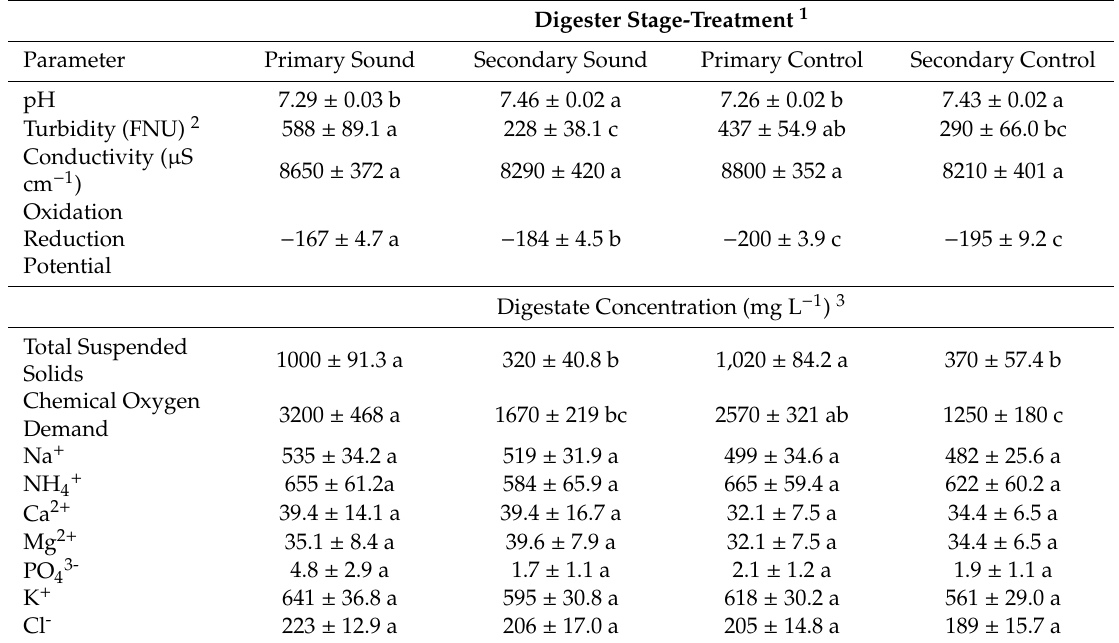
Table 3. Wastewater characteristics during principal evaluation period from July 3 through October